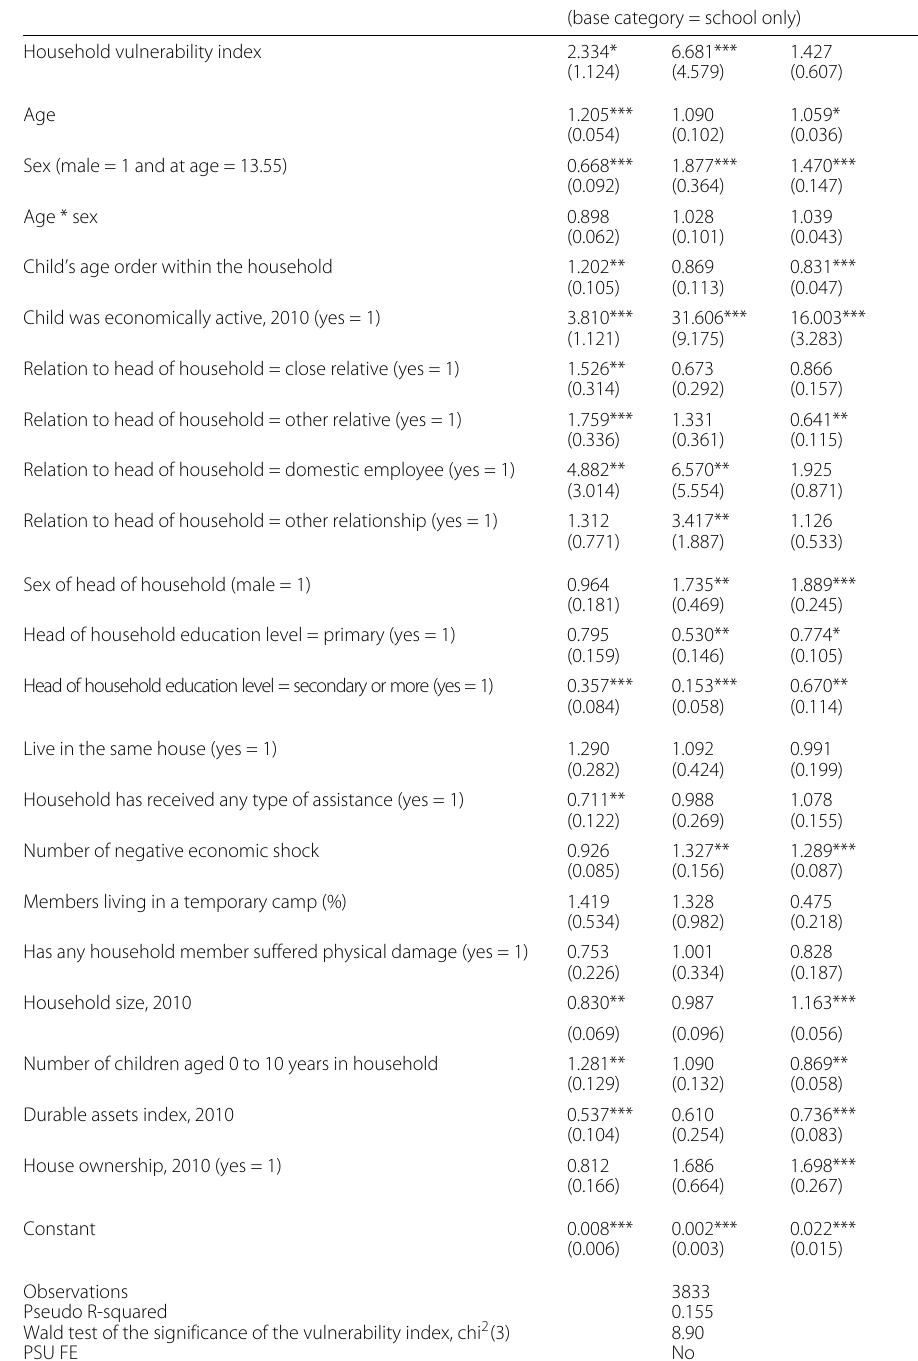
Table 3 MNL model for children’s time